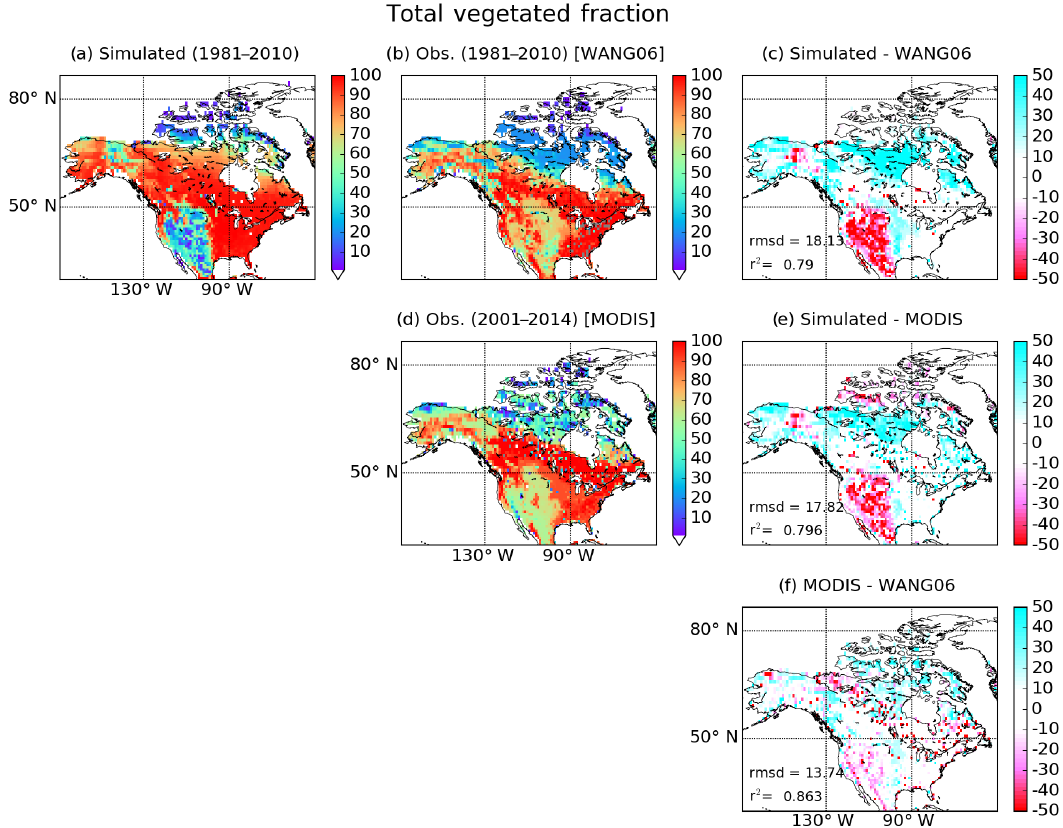
Figure 3. Spatial distribution of total vegetated coverage across North America. Model-simulated results are shown in the left column (a) and the two observation-based estimates are shown in the middle column (b, d) . The right column (c, e, f) shows the difference between model- and observation-based estimates (simulated minus WANG06 in c , and simulated minus MODIS in e ), and the observation-based estimates themselves (MODIS minus WANG06 in f ) along with the root mean square difference (rmsd) and spatial correlation ( R 2 ) between the two estimates being